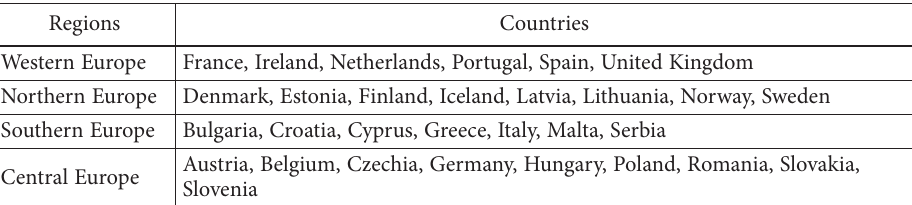
Table 2. The regional classification of the analysed European countries